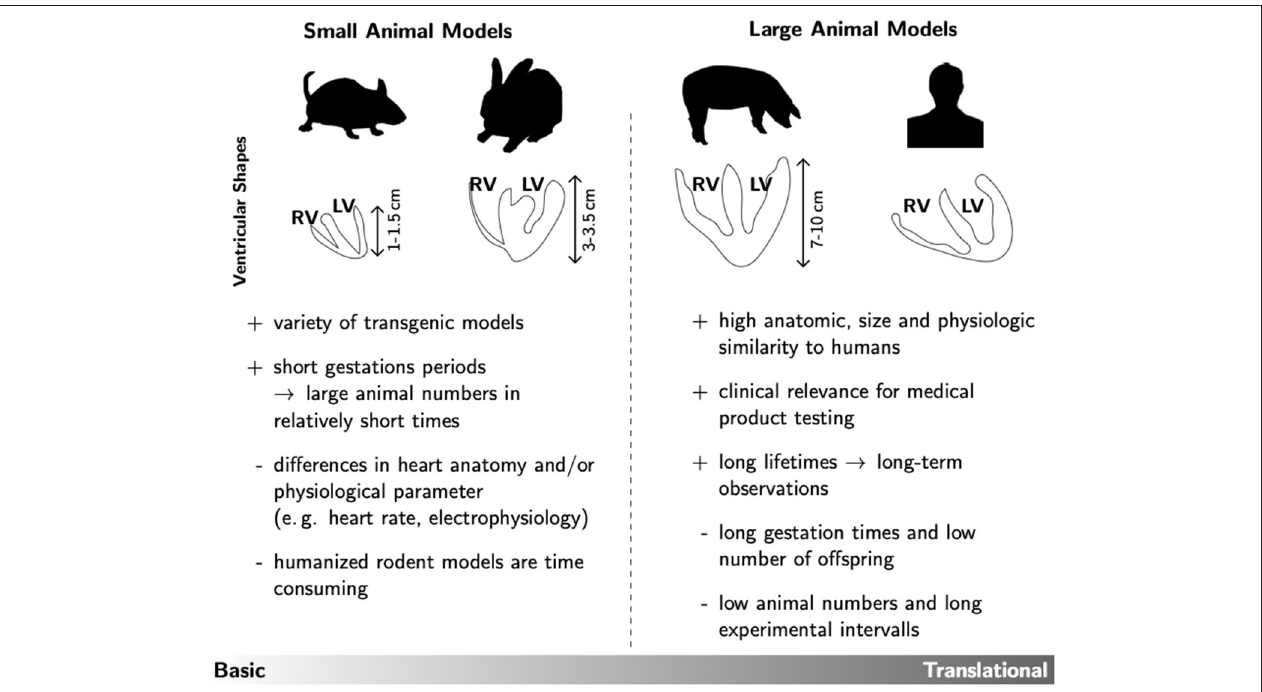
FIGURE 1 | Overview of the main advantages (+) and disadvantages (–) of small and large animal models. As prominent examples for each group the ventricular shapes of mice, rabbits, pigs and humans are shown. This rather technical drawing illustrates that the different species not only differ in heart size, but also in ventricular wall geometry. Such anatomic specifications could have significant influence on the experimental testing of prospective therapeutic approaches in e.g., cardiac rhythm